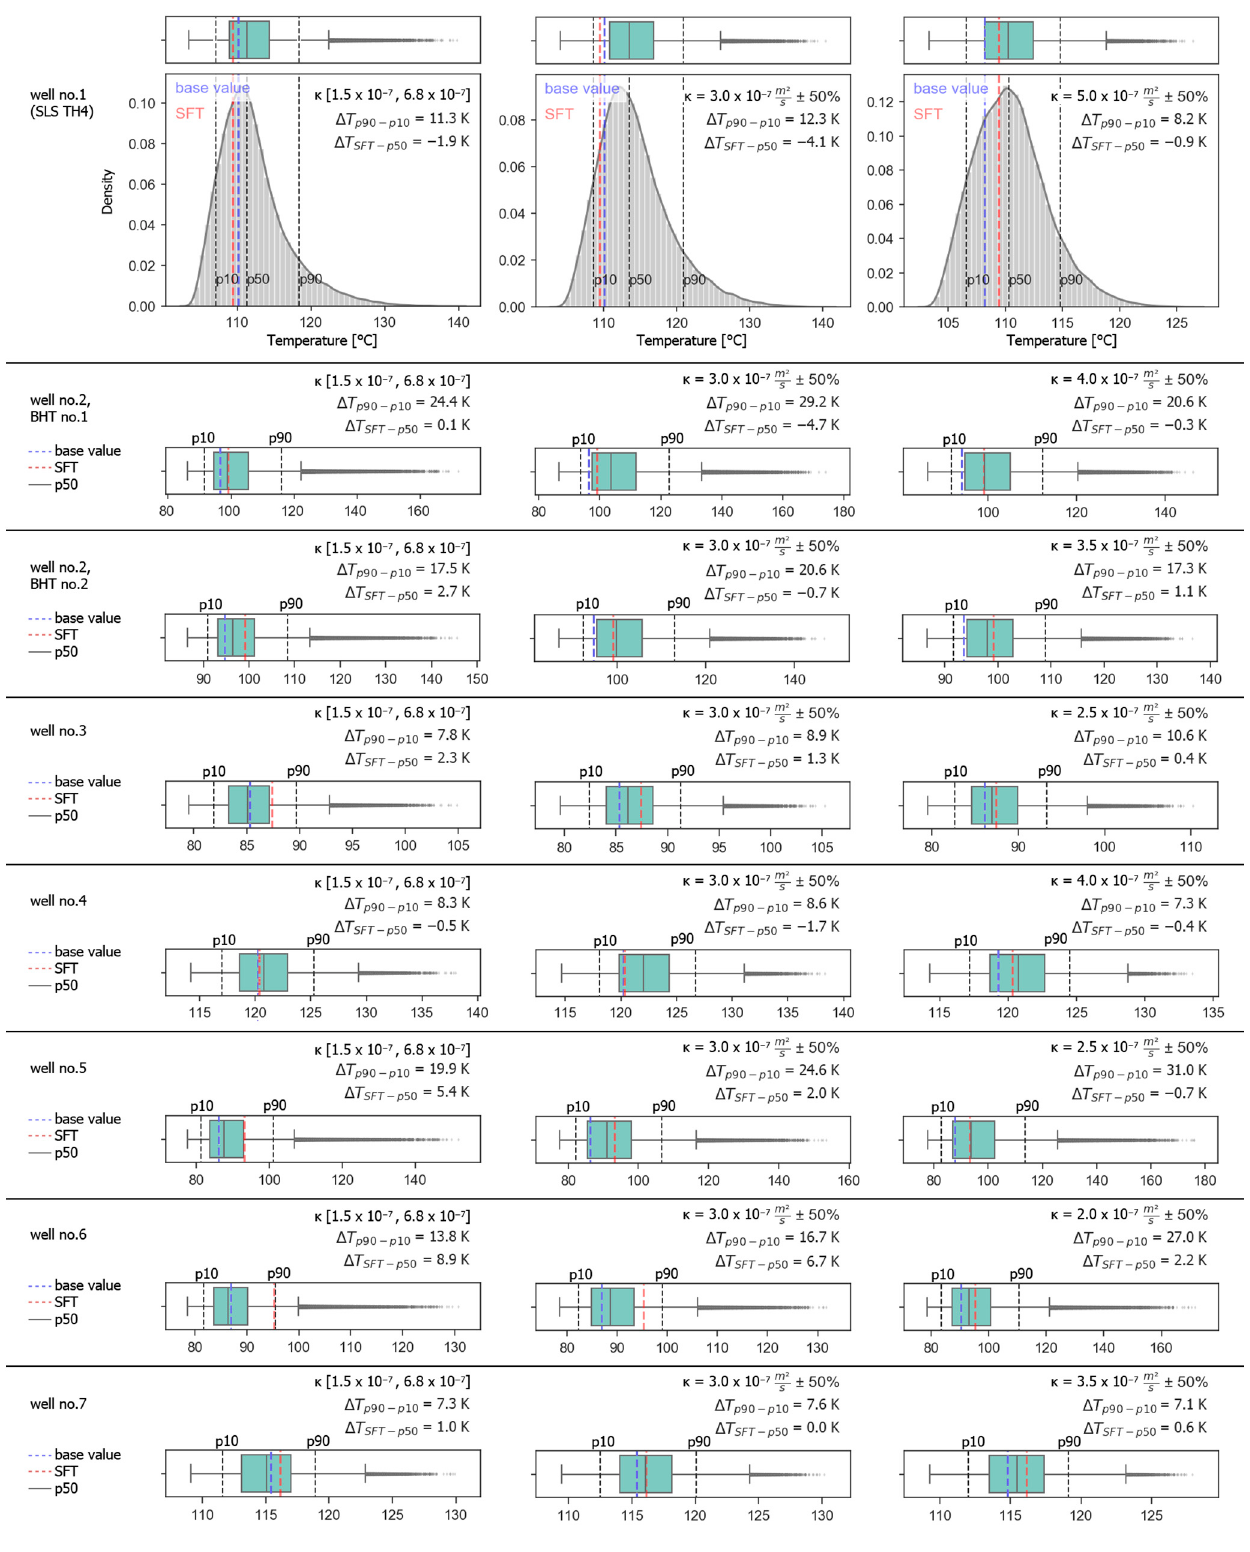
Figure 10. Corrected BHTs after running the 1BHTM with Saltelli sampling displayed as box plots. For well no. 1, the results are also shown in a density plot. SFT is shown as the red dashed line. p10 and p90 values are shown as the first and second black dashed lines. p50 (median) is displayed as the grey line in each box plot and the result at base value is displayed as the blue dashed line.